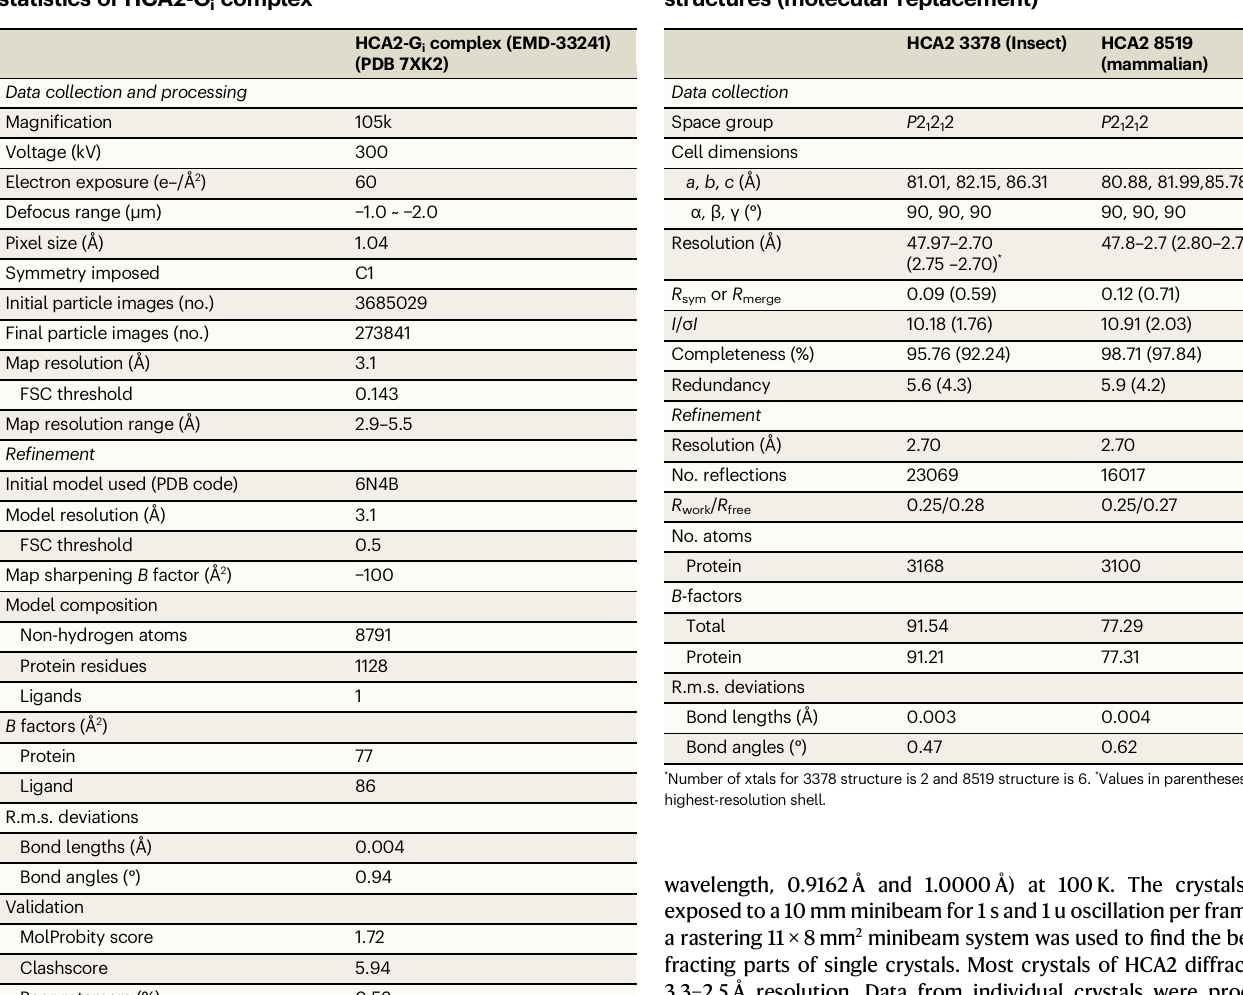
Table 2 | Data collection and re fi nement statistics of crystal structures (molecular